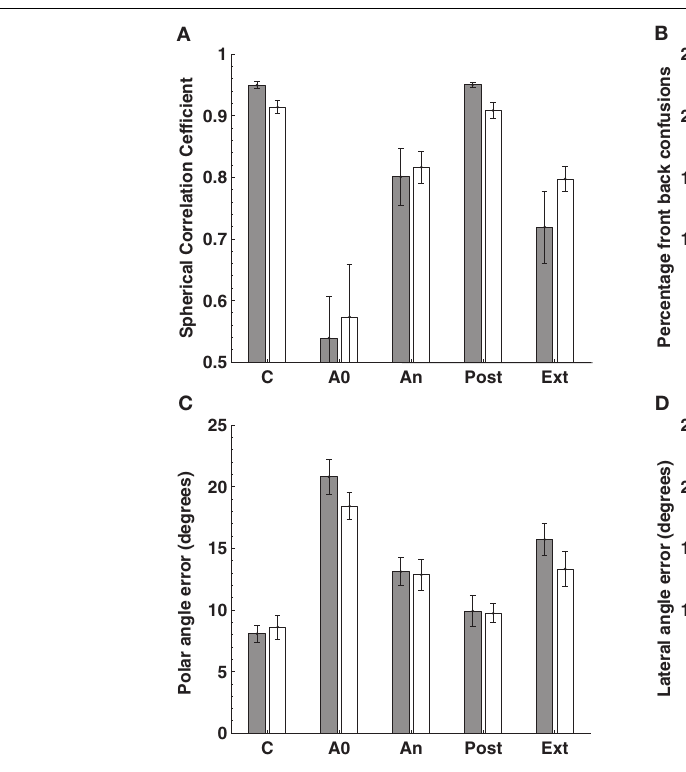
FIGURE 5 | Localization performance before, during, and after an accommodation period where spectrally distorting pinna molds were worn. Localization performance was measured using the (A) spherical correlation coefficient, (B) the percentage of front-back confusions, (C) the polar angle error (elevation error on the cone of confusion) and the (D) lateral angle (azimuth) error. The experimental manipulation is shown on the X-axis: C, control or baseline performance without the mold; A0 effect of acute